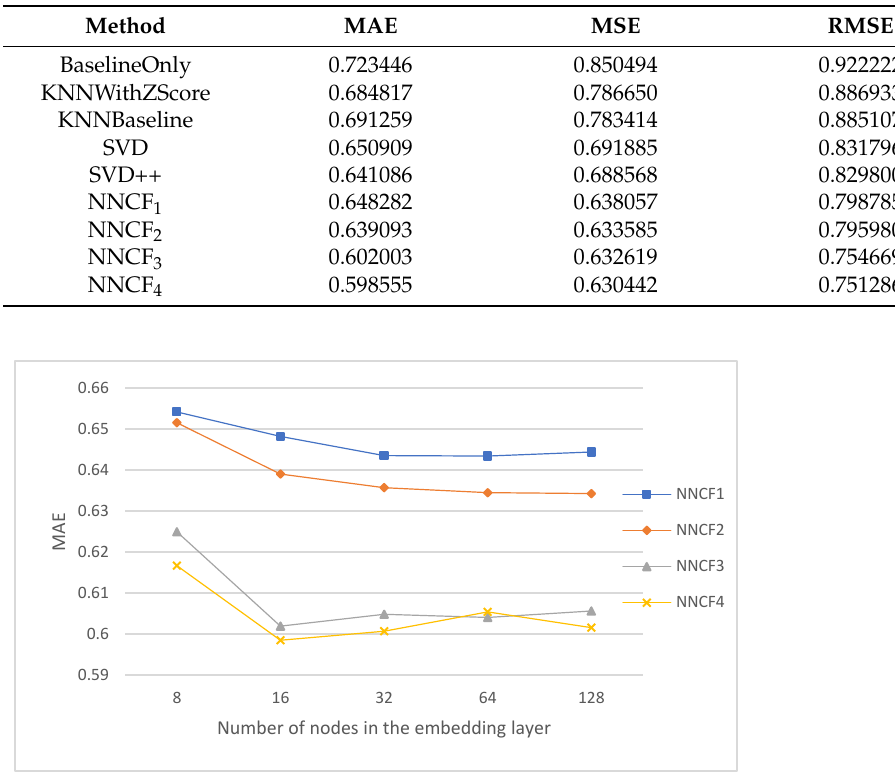
Table 7. The summary for the six DACR models.